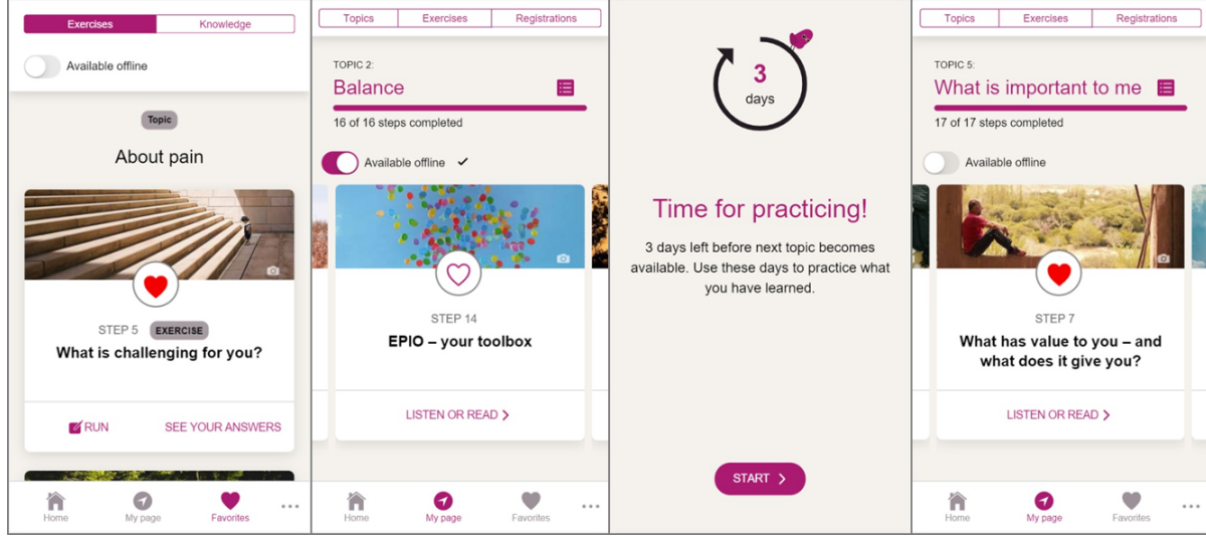
Figure 2. Example screenshots from the EPIO intervention program. From the left: (1) Exercise example about daily challenges; (2) Module about activity pacing; (3) Practicing mode; and (4) Module about